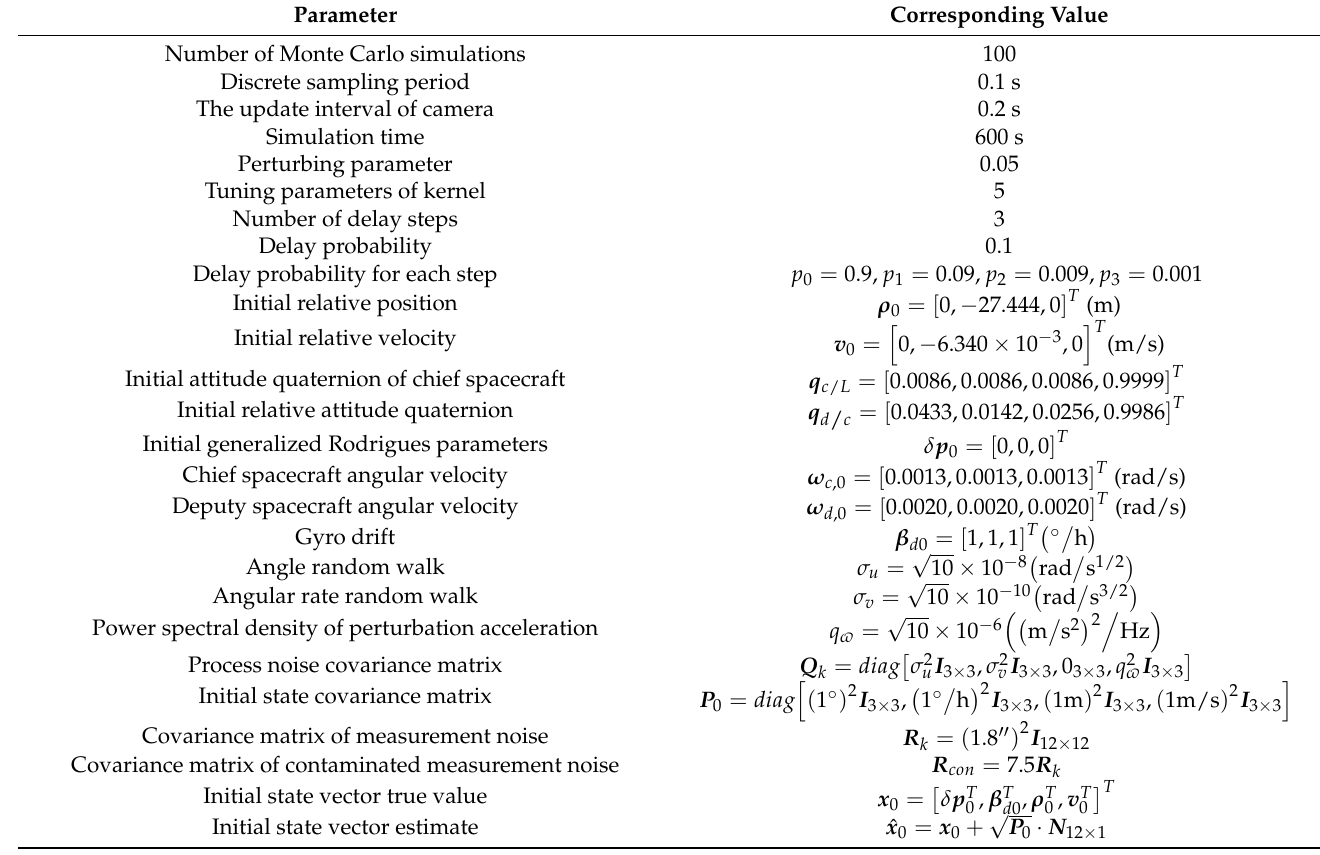
Table 3. Simulation